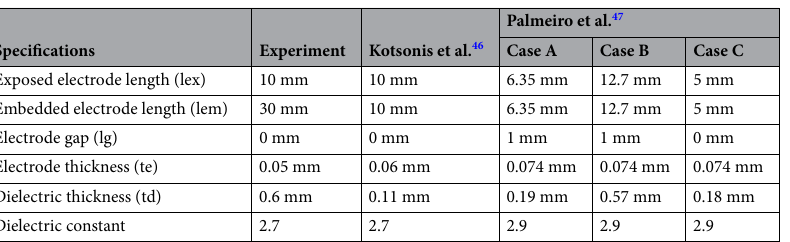
Table 2. The nominal experimental conditions and parameters as well as specifications and conditions for the study cases.